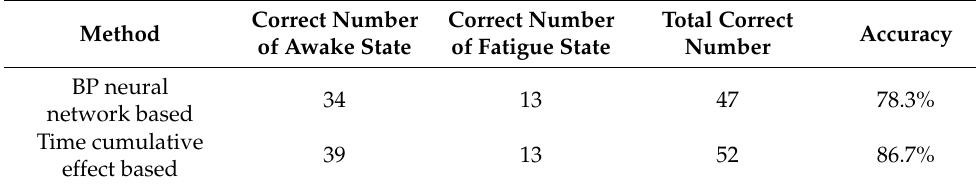
Table 6. Comparisons of fatigue detection results of the BP neural network model and the proposed time accumulation model for scenario